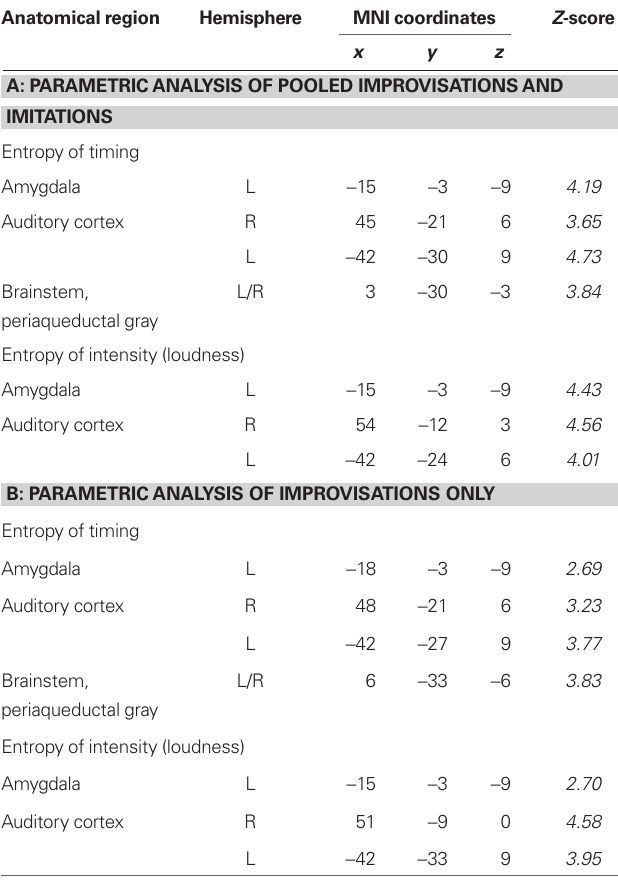
The values shown are Montreal Neurological Institute (MNI) coordinates for activation maxima of clusters in (A) and matching activation maxima in (B). R, right; L,